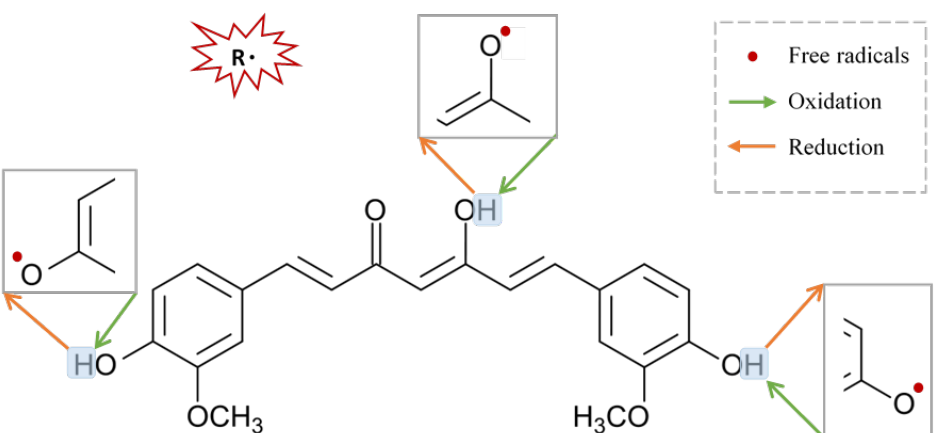
Figure 3. Suggested sites of exchange of phenol OH-group in curcumin structure with free radical oxidants, and its regeneration by a hydrogen donor antioxidant.